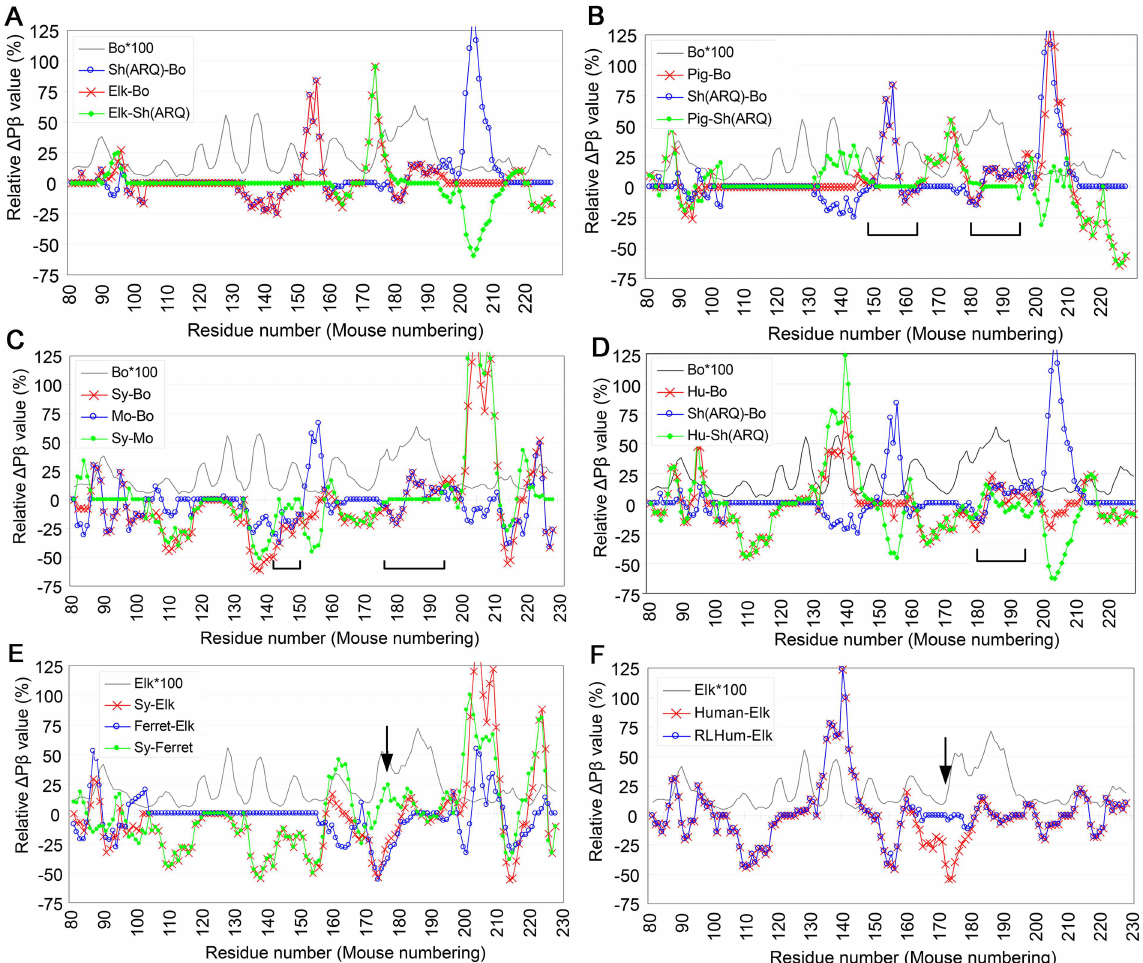
Fig 7. Relative Δ P β graphs of interspecies transmissions visually aid interpretation and are suggestive of how changes of host ranges could occur. A . Relative Δ P β graphs of transmissions of C-BSE from cattle to sheep with the ARQ polymorphism [Sh (ARQ)-Bo] and from cattle to Tg mice expressingelk PrP (Elk-Bo), and transmission of ovine PrP-adaptedC-BSE to Tg mice expressingelk PrP [Elk-Sh(ARQ)][26]. The latter speciesare donorsand the former speciesare recipients of transmissions. The blue, red and green curves represent efficient, inefficient and improvedtransmissions, respectively. B . Relative Δ P β graphs of transmissions of C-BSE from cattle to Tg mice expressingporcine PrP (Pig-Bo) and of ovine PrP-adapted C-BSE to Tg mice expressingporcinePrP [Pig-Sh(ARQ)]. The bottom brackets indicate regions flattenedby passagethrough sheep[27]. C . Relative Δ P β graphsof transmissionsof C-BSE from cattle to mouse (Mo-Bo) and Syrian hamster (Sy-Bo) and from mouse-adapted C-BSE to Syrian hamster (Sy-Mo) [28]. D . Relative Δ P β graphs of transmissions of C-BSE from cattle to Tg mice expressinghuman PrP (Hu- Bo) and of ovine PrP-adapted C-BSE to human[Hu-Sh(ARQ)] [25]. E . Relative Δ P β graphs of transmissions of CWD from elk to ferret (Ferret-Elk) and to Syrian hamster (Sy-Elk) and from ferret-adapted CWD to Syrian hamster (Sy-Ferret). The large negative peak at aroundresidue 175 disappeared after passagethrough ferret (arrow) [29]. F . Relative Δ P β graphs of transmissions of CWD from elk to Tg mice expressinghumanPrP (Human-Elk) and to Tg mice expressinghuman PrP with elk residuesin the regionof residues 166–174(RLHuman-Elk) [31]. The arrow indicatesthe regionin which the graph pattern was changedby